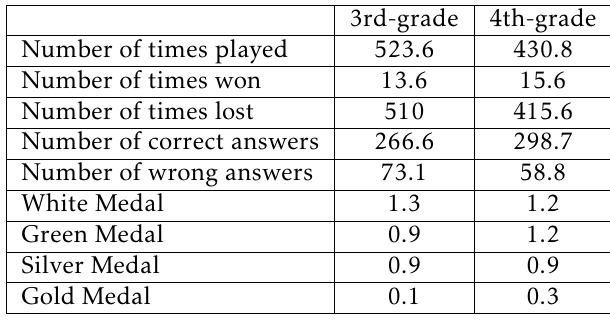
Table 4. Mean of the data recorded for 3rd and 4th-grade.